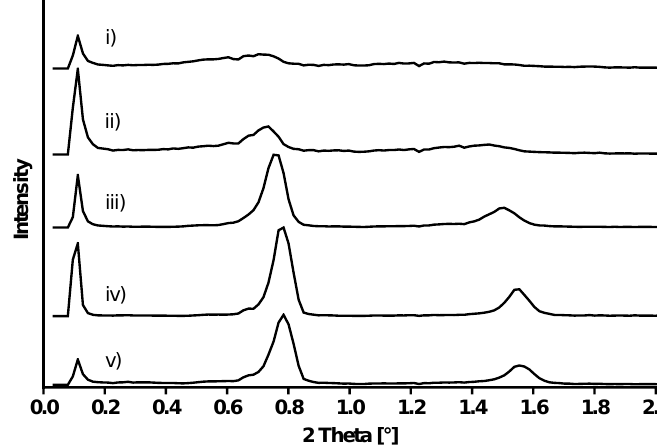
Figure 12. SAXS diffraction patterns of mixed crystals of (i) cetostearyl alcohol, polysorbate 60 and water in the presence of (ii) 2-methyl-2,4-pentanediol, (iii) 1,2-pentanediol, (iv) 1,2-hexanediol, (v) 1,2-octanediol. Table 4. Lamellar distances of mixed crystals of cetostearyl alcohol, polysorbate 60, water and in the presence of different alkanediols.